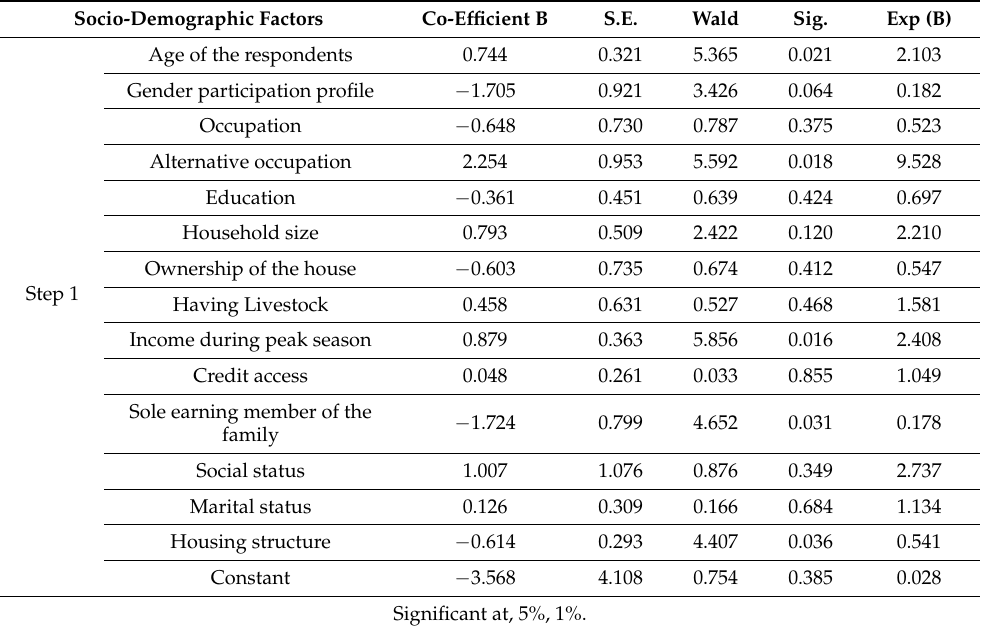
Table 5. Determinants of the factors affecting the food security of people participating in fish drying